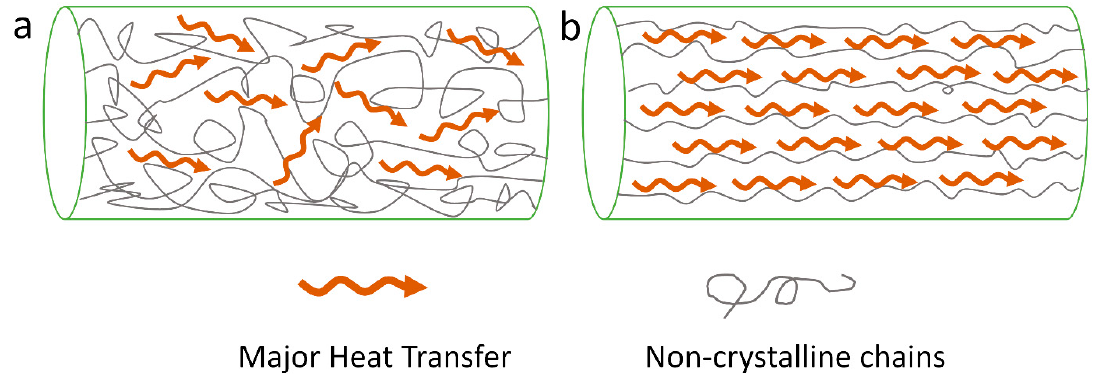
Figure 5. Effect of molecular chain alignment on heat transfer: ( a ) structure of bulk non-crystalized polymer with less chain alignment; ( b ) structure of stretched non-crystalized polymer with good chain orientation.